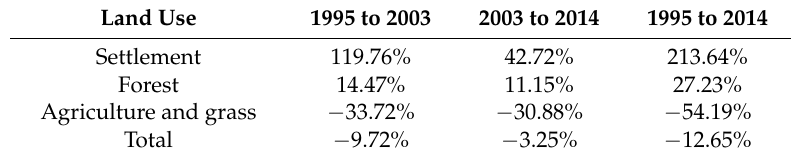
Table 5. GPP estimation changes in each type of land use in Denpasar from 1995 to 2014. Land Use